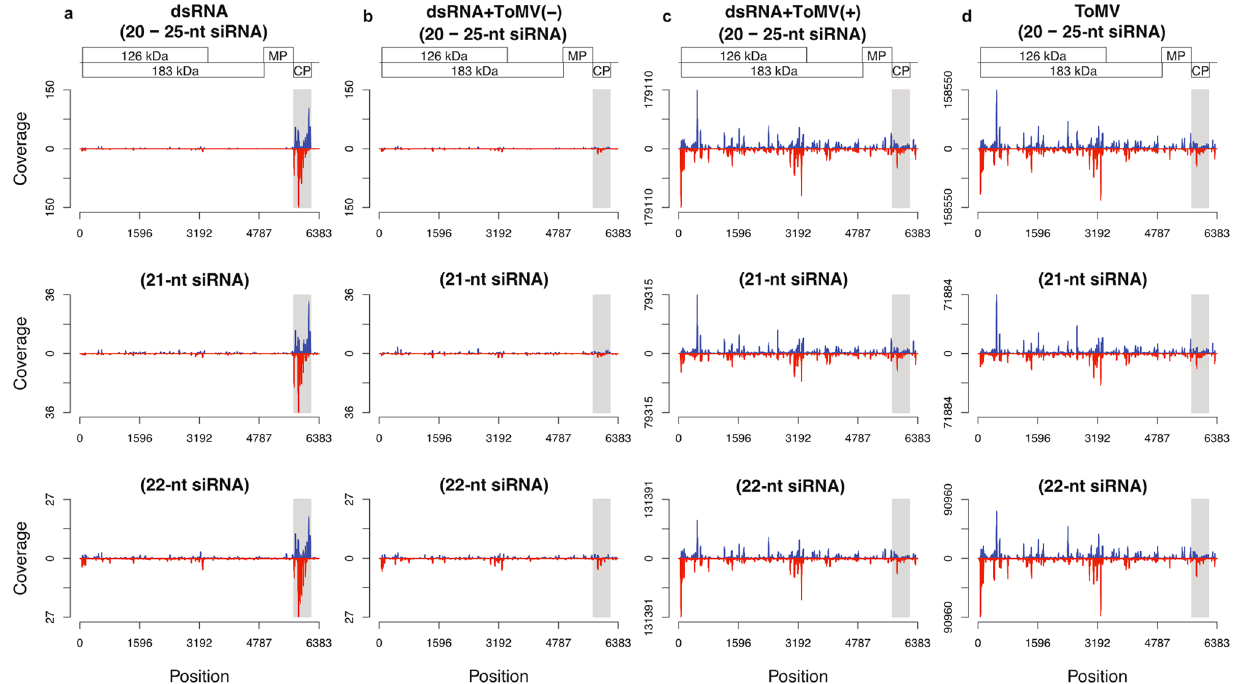
Figure 9. Single-nucleotide resolution maps of small interfering RNA (siRNA) in tomato plants from four libraries: dsRNA ( a ), dsRNA + ToMV(−) ( b ), dsRNA + ToMV(+) ( c ), and ToMV ( d ). Histograms plot the numbers from 20- to 25-nt, 21-nt and 22-nt viral siRNA reads at each ToMV-genome nucleotide position. The results are expressed as average values of three repetitions (each composed of four plants) per treatment. Sense- strand reads are shown above the X axis; antisense-strand reads are shown below the X axis, representing the ToMV genome. Scaled ToMV genome diagram is shown above the histograms, and the corresponding position below the diagram. Y axis represents the coverage in number of